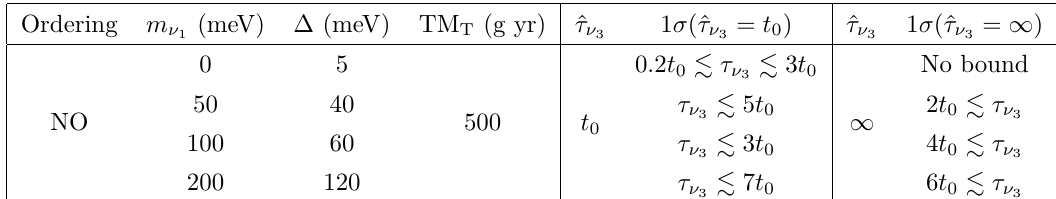
at 1 σ confidence level for ν 3